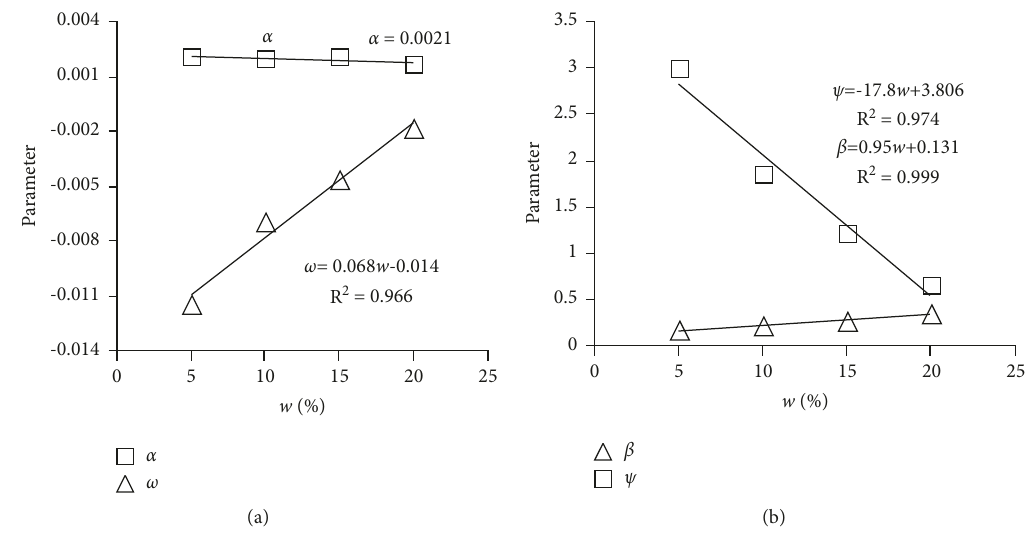
Figure 11: Parameters α , β , ω , and ψ versus water content. Table 1: Equivalent cycles versus earthquake magnitude. Earthquake